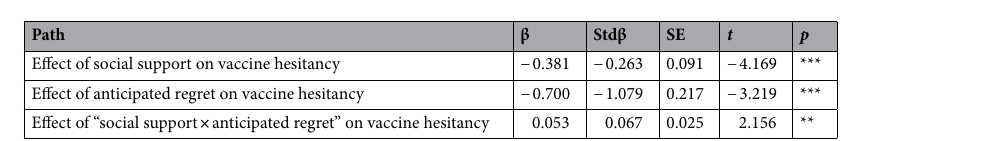
Table 9. The moderating effect of social support on the relationship between anticipated regret and vaccine hesitancy. Social support—moderating variable; anticipated regret—one of the TPB dimensions; β— unstandardised beta co-efficient; Stdβ—standardised beta co-efficient; SE—standard error; t—t value, p — shows the significant level; All parameters obtained from the AMOS output. *** p < 0.001; ** p < 0.05.